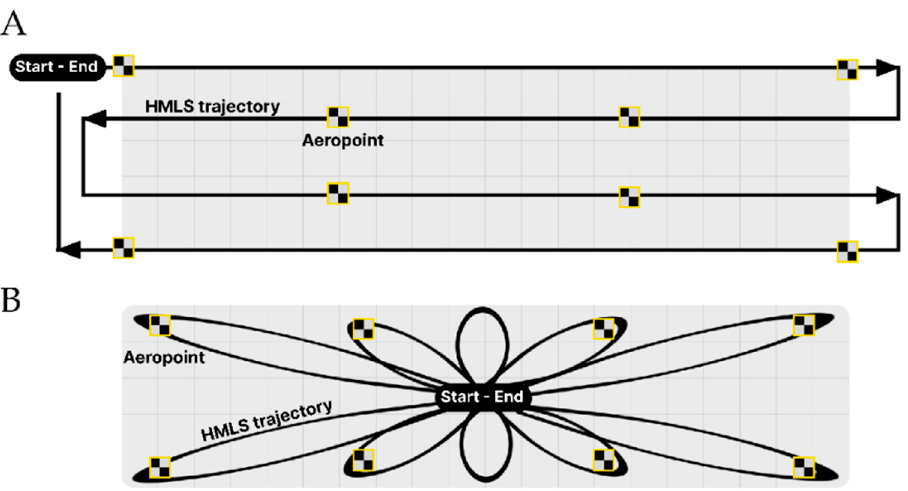
Figure 3. Two HMLS scan trajectories were tested for point cloud data collection: ( A ) zigzag trajectory, and ( B ) looped trajectory. The eight AeroPoints TM (in yellow/black squares) are used to generate fixed GPS points for georeferencing to the Dutch coordinate system (RD New).